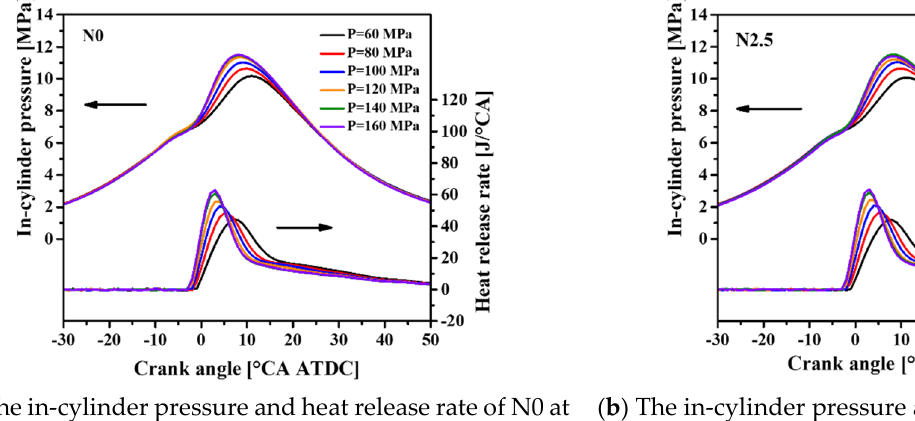
( a ) The in-cylinder pressure and heat release rate of N0 at different injection pressures.